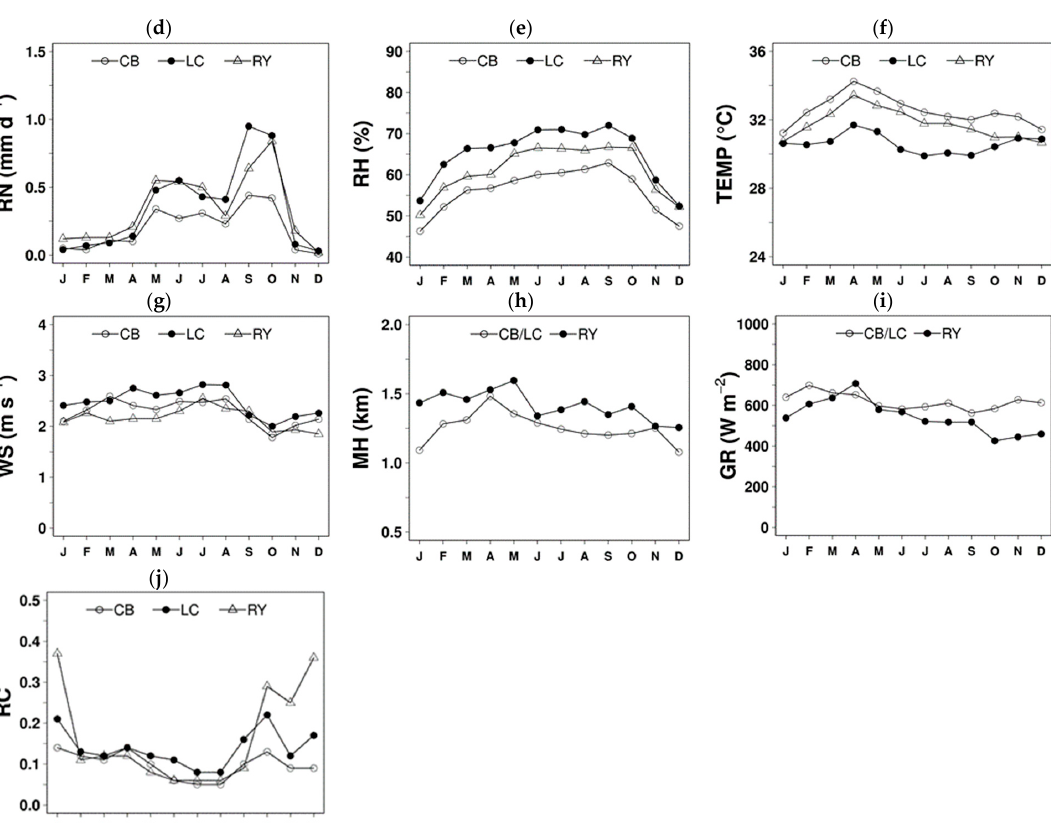
Figure 3. Monthly variation of ( a ) visibility (before met-screening); ( b ) visibility; ( c ) PM 10 ; ( d ) rain; ( e ) relative humidity; ( f ) temperature; ( g ) wind speed; ( h ) mixing height; ( i ) global radiation; and ( j ) recirculation factor.